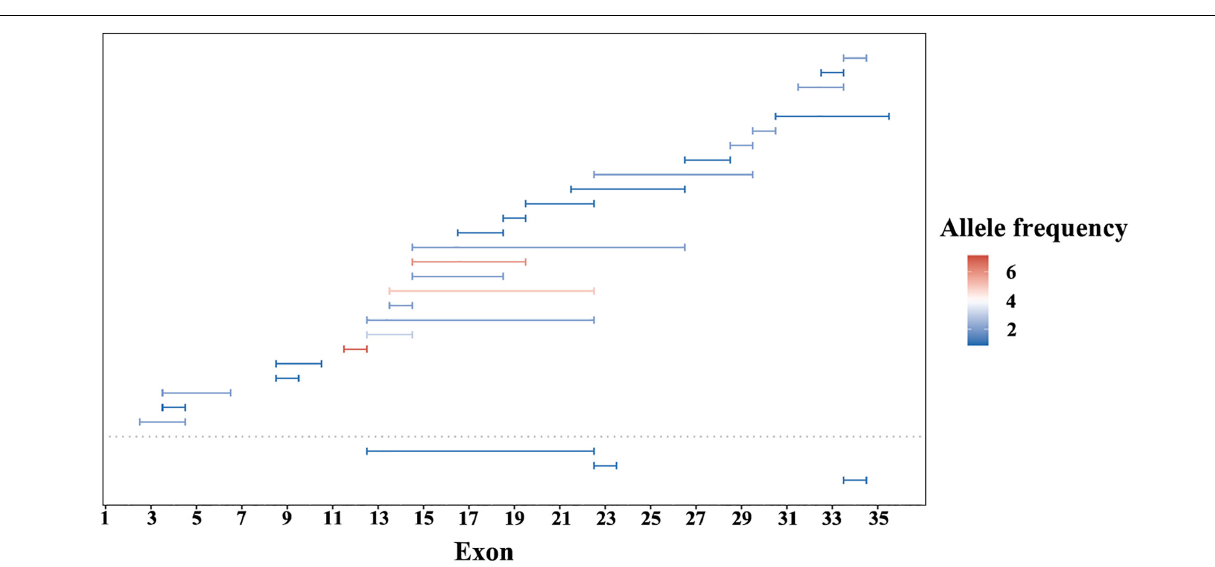
(NM_001142800) were validated using Sanger sequencing.